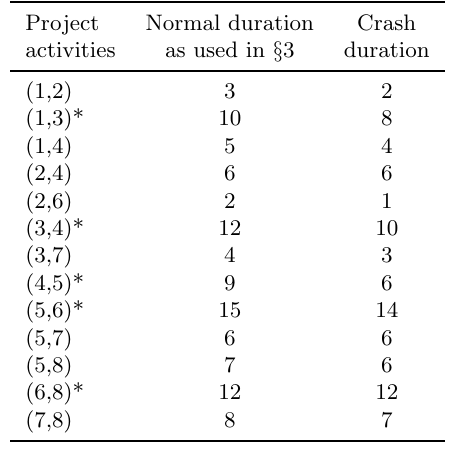
Table 3: Data on the normal and crash durations of activities in the CPM nerwork in Figure 2. Asterisks indicate critical activities and the crash durations in the last column are assumed (given) values for illustration.